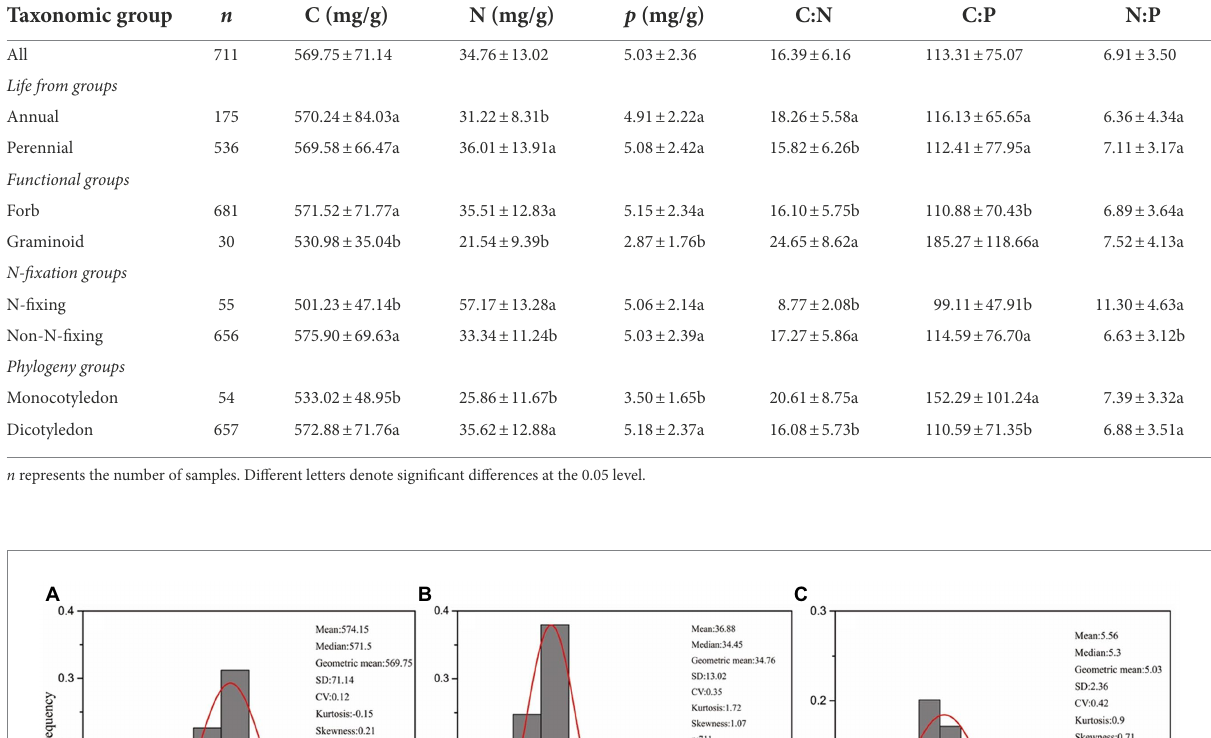
TABLE 1 Geometric means and standard deviations of seed C, N, and P concentrations and their ratios for major plant groups. Taxonomic group